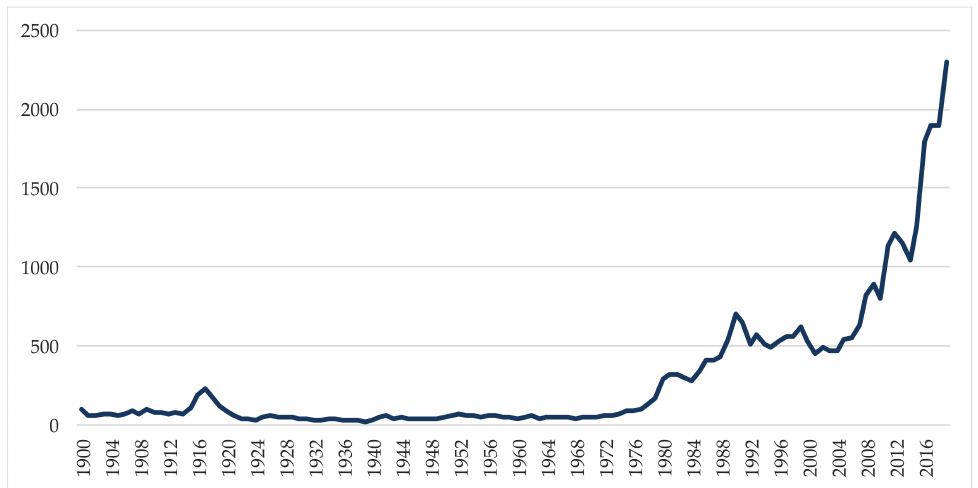
Figure A8. Copper price dynamics in USD/t (build on the data from [25]), the red line is a trend. Figure A7. Graphite price dynamics in USD/t (build on the data from